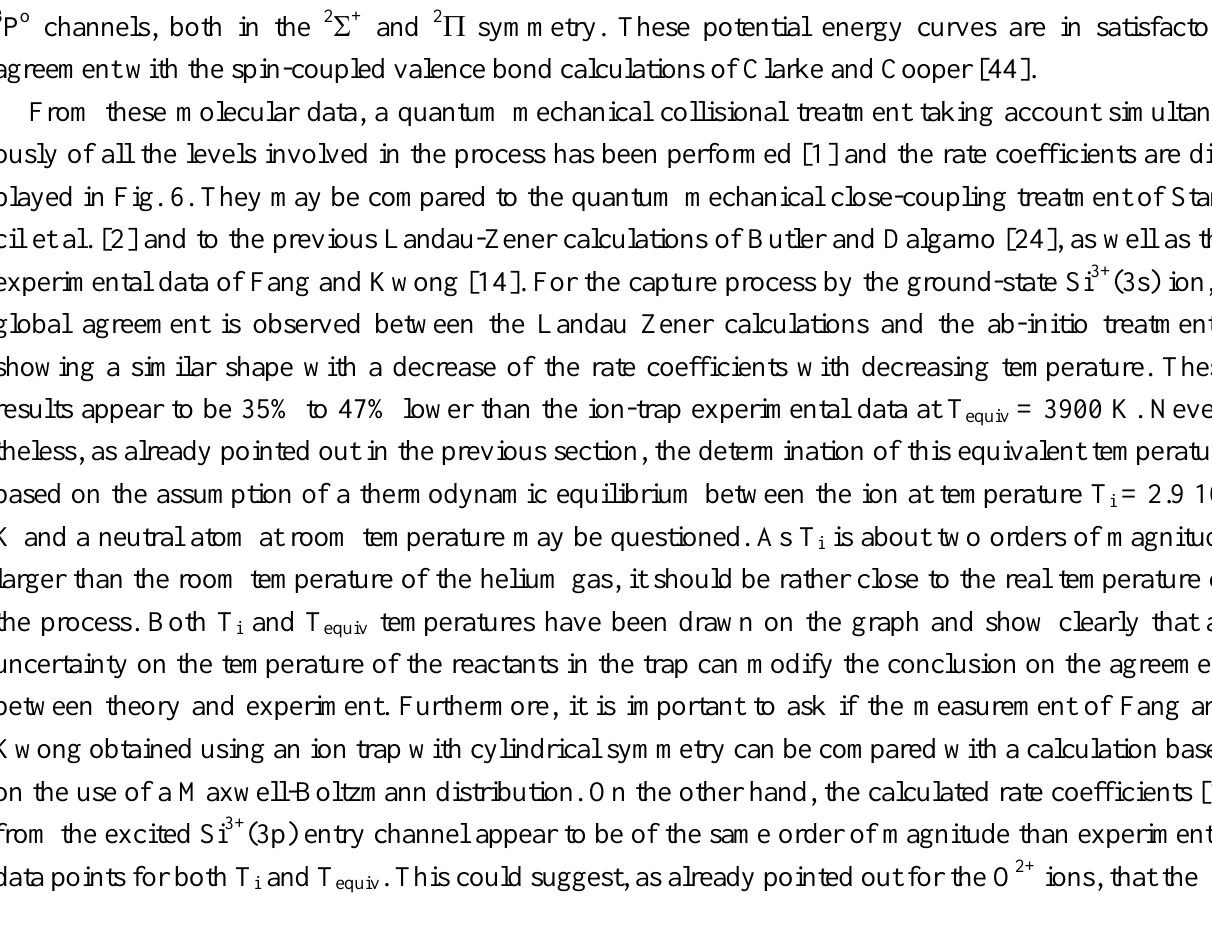
Fig. 5a,b : Adiabatic potential energy curves for respectively the 2 Σ + and 2 Π states of Si 3+ + He [1]. Si 2+ (3s3p) 3 P o + He + (1s) 2 S level around R=3.2 a.u. The excited Si 3+ (3p) entry channel shows impor- tant avoided crossings around R=7 a.u. and 5 a.u. with respectively the Si 2+ (3s3p) 1 P o and Si 2+ (3s3p) 3 P o channels, both in the 2 Σ + and 2 Π symmetry. These potential energy curves are in